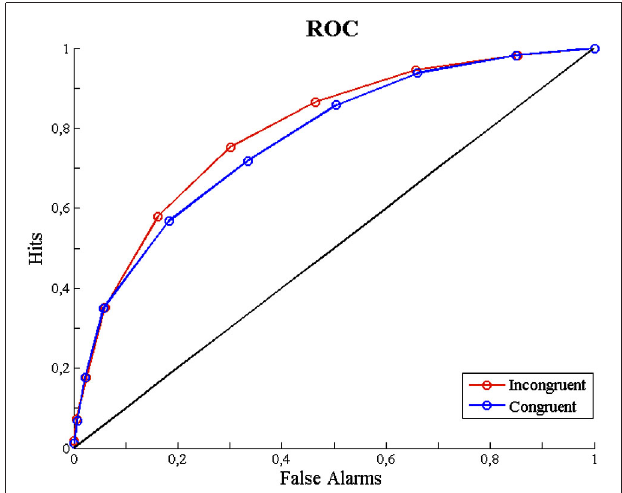
FIGURE 2 | Contrast effect: ERP and Topography . This figure presents the mean ERPs on O1 Oz O2 for C0 (in blue) and C1 (in red) from − 500 to 980 ms relative to stimulus apparition. The blued surface represents the analysis time window (from 180 to 320 ms, centered on the pic around 250 ms). In the top left corner the topography of the difference (C1 – C0) is presented for the analysis time window. * p <